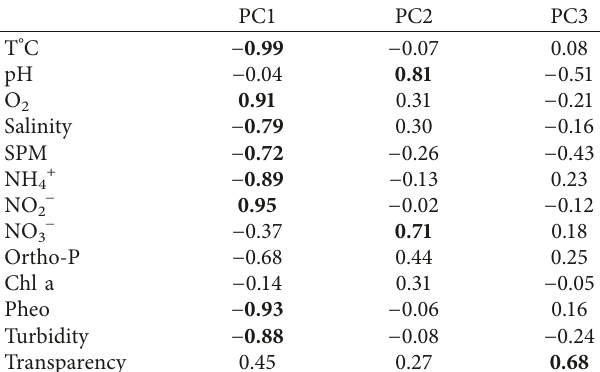
Table 3: Results of principal component analysis are shown as correlation values between the variables and the principal com- ponents for the first three principal components